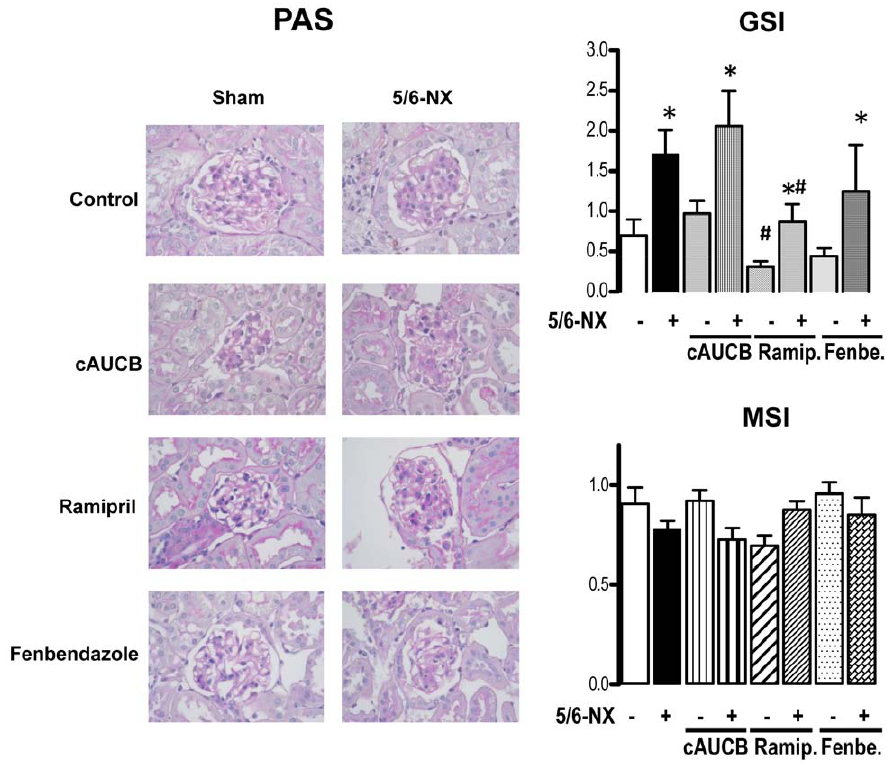
Figure 2. Histological glomerular changes. Representative kidney sections (magnification 6 400) stained by periodide acid - Schiff (PAS) scoring glomerulosclerosis index (GSI) and mesangiolysis score (MSI) after 8 weeks of treatment. Effects of placebo, sEH-inhibition by cAUCB, ACE-inhibition by ramipril (Ramip.) and CYP-inhibition by fenbendazole (Fenbe.) are shown on sham operated ( 2 ) and 5-6-Nx ( + ) animals. * p , 0,05 vs. sham, # p , 0,05 vs. placebo (n=5–8/group).